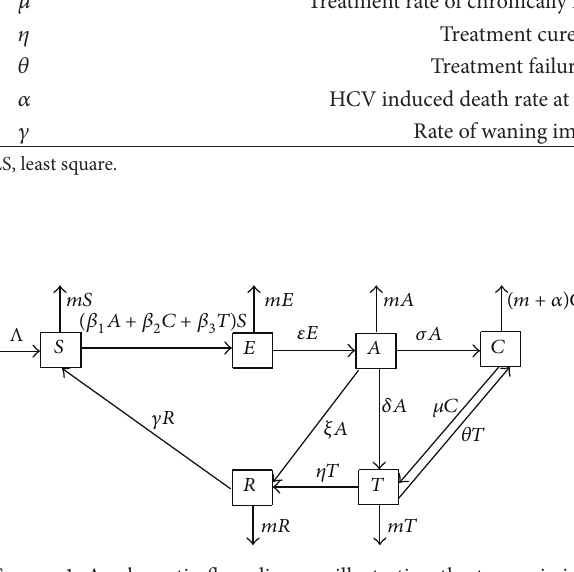
Figure 1: A schematic flow diagram illustrating the transmission dynamics of the HCV infection with